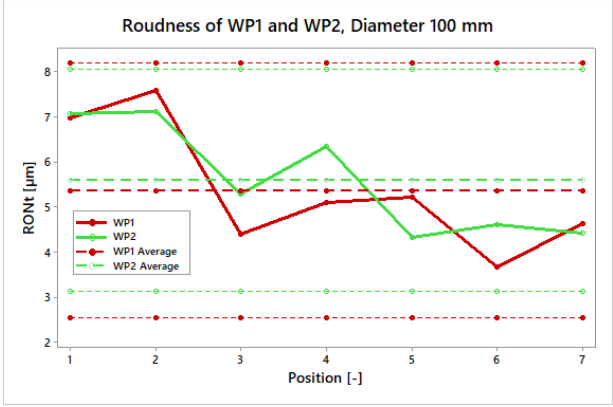
Figure 16. Evaluation of RONt, 100 mm diameter.